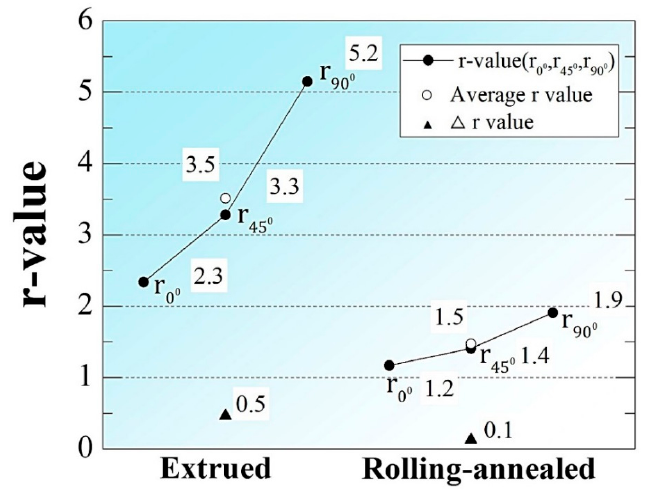
Figure 8. The r -value of ATM610 alloy sheets.